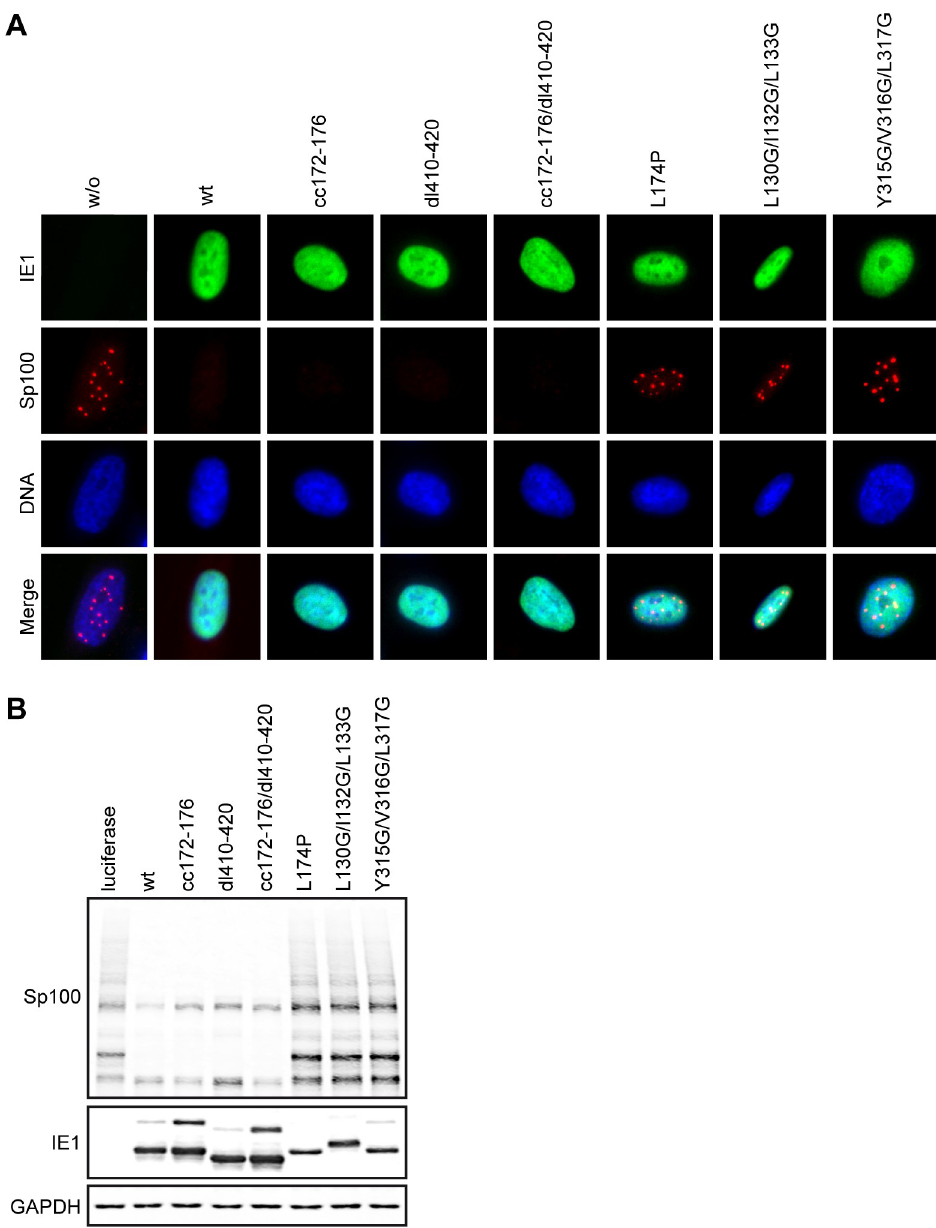
Fig 7. Distinction between Sp100 degradation and PML interaction by IE1. (A) TetR (w/o) and TetR-IE1 cells expressing the indicated HA-tagged wild-type (wt) or mutant IE1 proteins were treated with dox for 24 h. Indirect immunofluorescence staining was performed using mouse anti-HA (IE1) and rabbit anti-Sp100 combined with goat anti-mouse Alexa Fluor 488 and goat anti-rabbit Alexa Fluor 594 antibodies. DAPI was used to stain DNA. Images from interphase cells showing the typical staining pattern of IE1 and Sp100 relative to DNA are presented along with merge images (Keyence BZ-9000 microscope, 100 × objective). (B) TetR cells expressing firefly luciferase and TetR-IE1 cells expressing the indicated HA-tagged wild-type (wt) or mutant IE1 proteins were treated with dox for 48 h. Whole cell extracts prepared in buffer (pH 8.0) with NEM were subjected to immunoblotting for Sp100, IE1 (mouse anti-HA) and